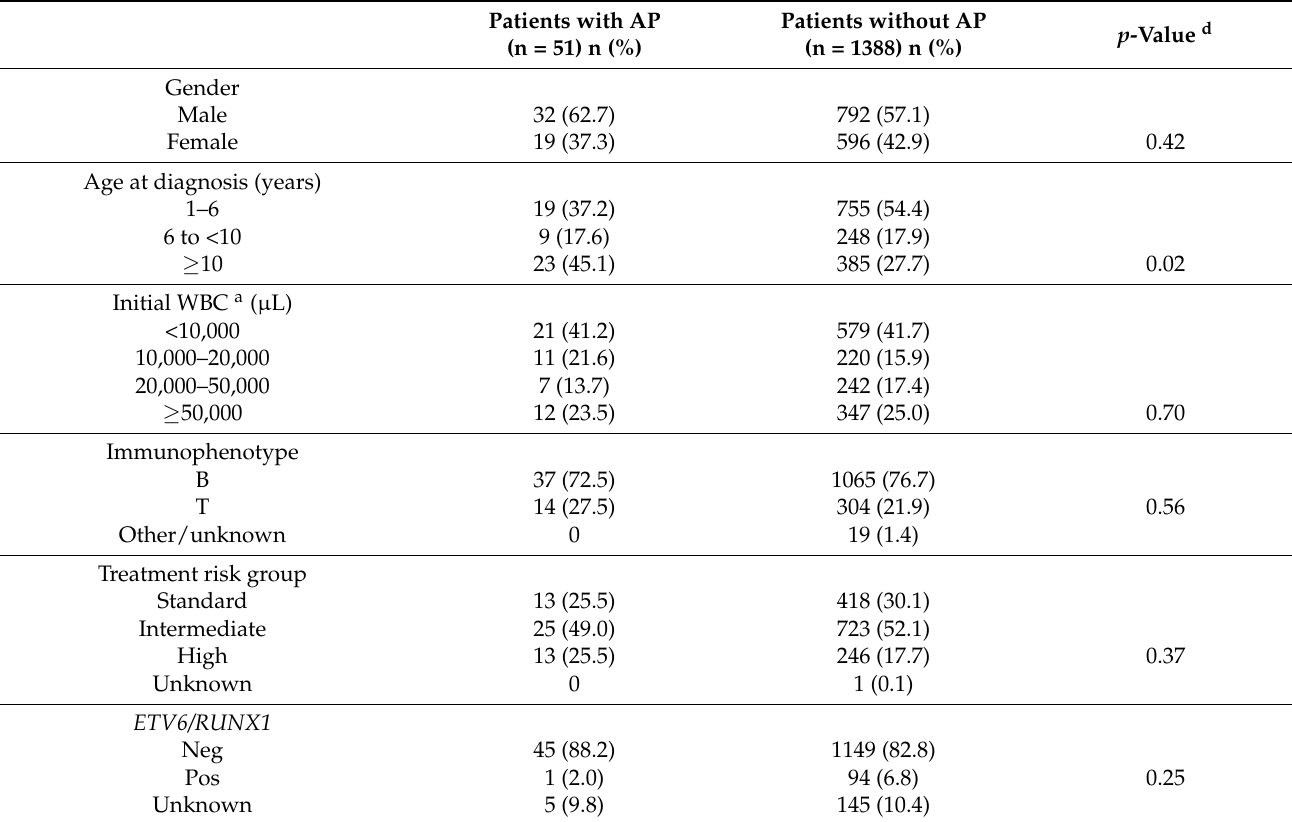
Table 1. Clinical characteristics of 1439 patients with ALL from trial AIEOP-BFM ALL 2000 (GWAS cohort) according to the acute pancreatitis (AP) status. Patients with AP Patients without